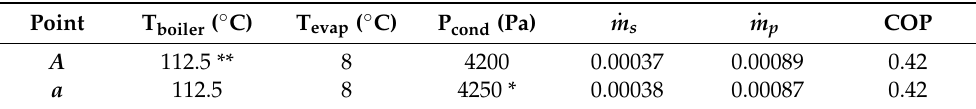
Table 2. Comparison of the performance of the steam ejector refrigerator at the optimal operation with the critical